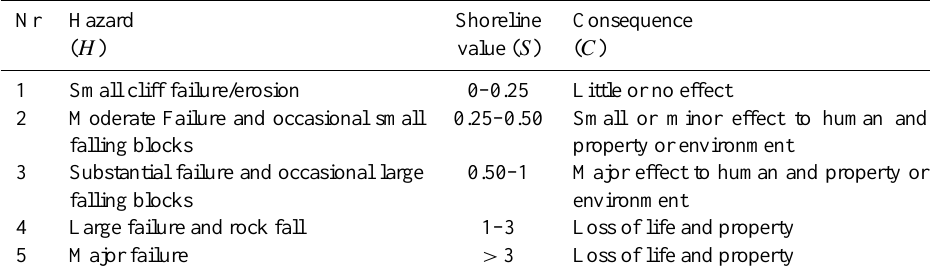
Table 5. Hazard and shoreline retreat value classifications.